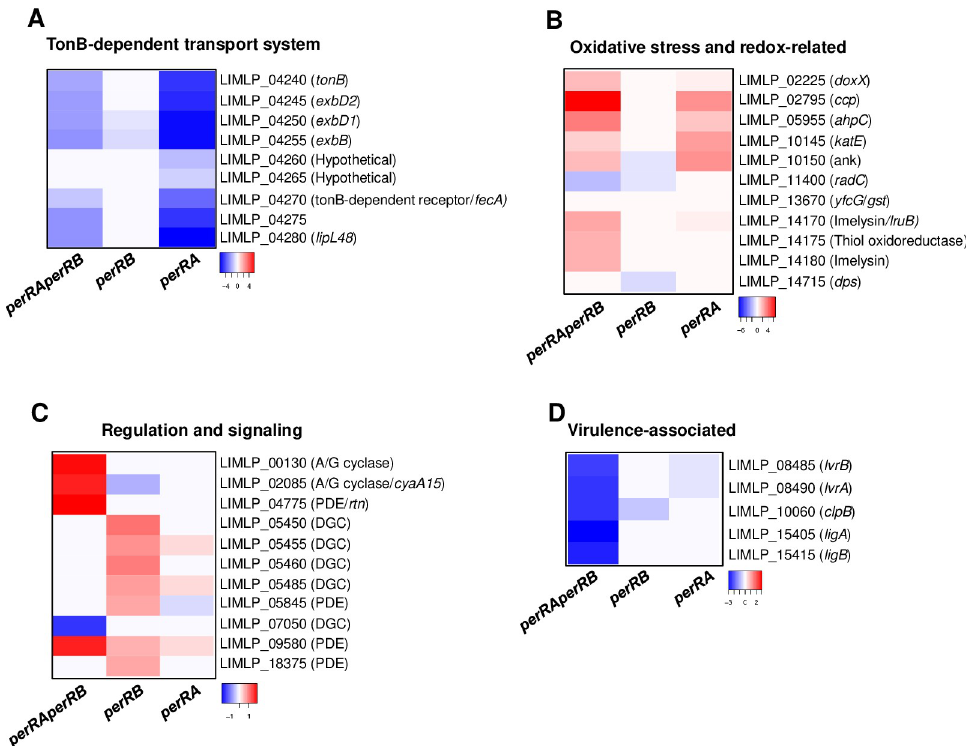
Fig 9. Comparison of differential gene expression in the double perRAperRB mutant with that in the single perRA and perRB mutants. Expression of selected genes of the TonB-dependent transport cluster (A), involved in oxidative stress and redox homeostasis (B), in regulation and signaling (C), and in virulence (D) determined by RNASeq in the double perRAperRB mutant was compared to those in the single perRA mutant determined by Zavala-Alvarado et al . [19] and single perRB mutant (as determined in this study). Differential expression in each mutant strain was normalized with that in the WT strain. Gene names are indicated on the right. The Heat Map color from blue to red indicates low to high Log 2